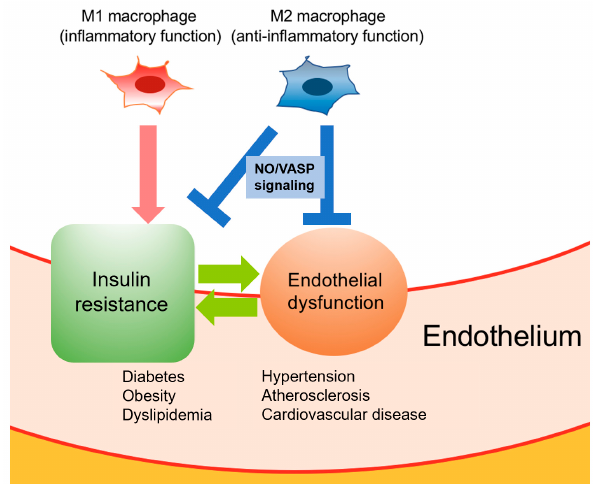
Figure 1. The metabolic network between macrophage polarization, insulin resistance, and endothelial cells. Macrophages play pleiotropic functions in the endothelium. Proinflammatory M1 macrophages are stimulated by LPS, IFN- γ , and TNF- α and promote the secretion of inflammatory cytokines, including IL-1, IL-6, and TNF- α . In contrast, anti-inflammatory M2 macrophages are stimulated by IL-4 and IL-10 and secrete anti-inflammatory cytokines, such as IL-10 and TGF- β . Through NO/VASP signaling, M2 macrophages contribute to the suppression of inflammation in the endothelium, leading to the improvement of insulin resistance and endothelial dysfunction. NO, Nitric oxide; VASP, Vasodilator-stimulated phosphoprotein.